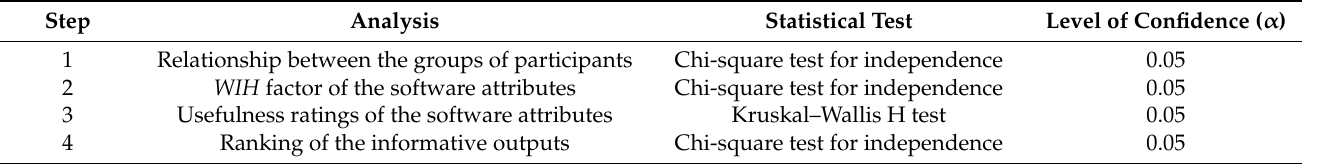
Table 4. Statistical tests performed in each step.